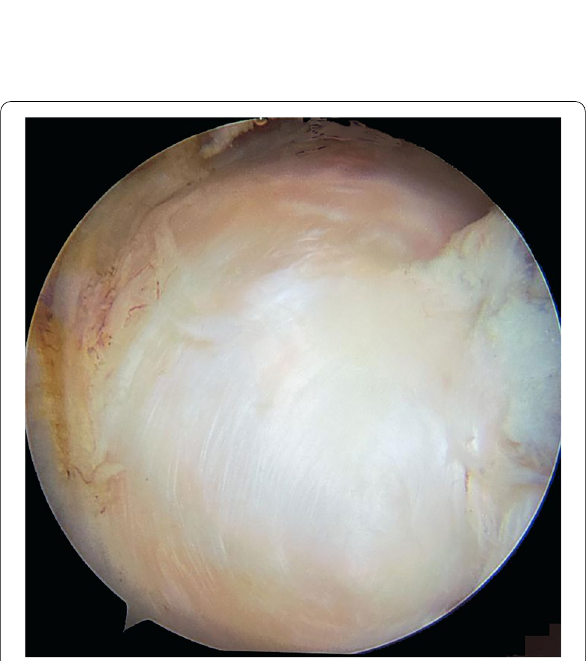
Fig. 2 Macroscopic appearance of the repair of a complete tear at 6 months follow‑up shows complete healing of the lesion. The second look arthroscopy was performed in the patient who was reoperated on due to arthrofibrosis